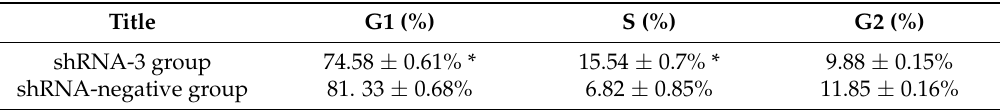
Measurement of the cell cycle by flow cytometry at 48 h after transduction with the shRNA-3 lentivirus and the shRNA-negative lentivirus (mean ± SEM, n = 3). All results were evaluated by one-way ANOVA. An asterisk (*) indicates the level of significance of the column ( p < 0.05).